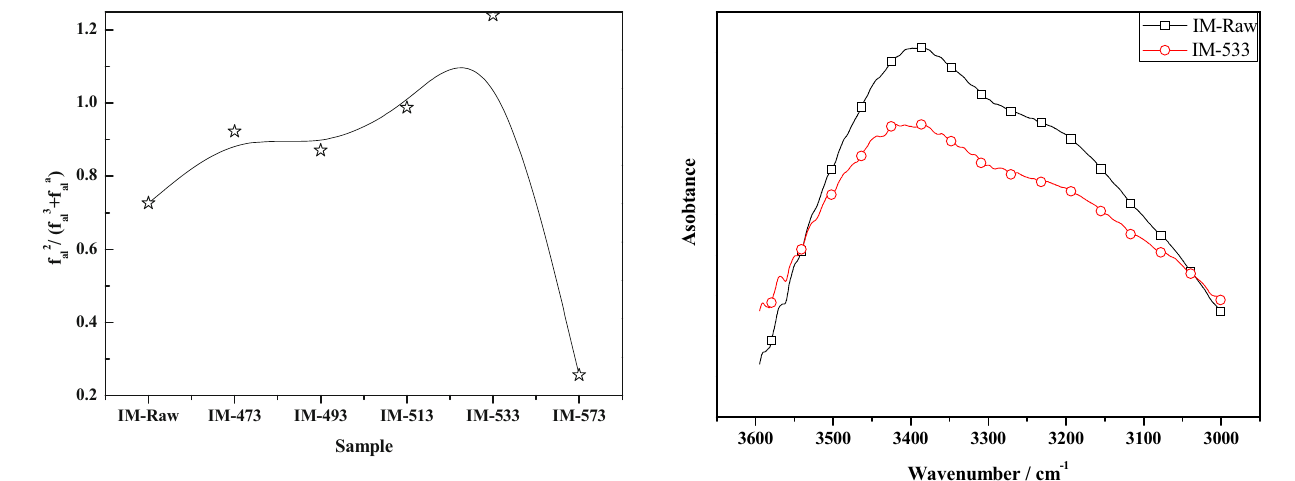
Fig. 6 Variation of the CH 2 /CH 3 ratio